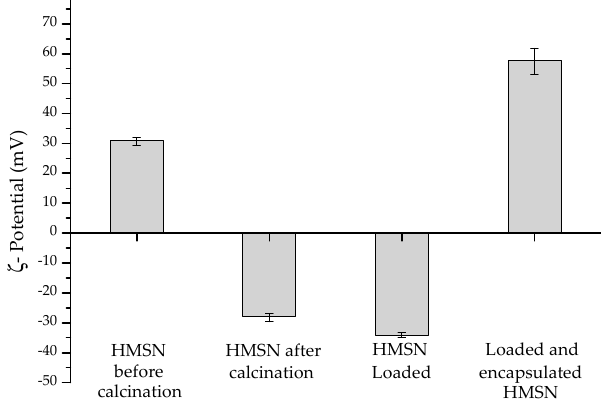
Figure 5. ζ -Potential values of HMSN at each different stage.